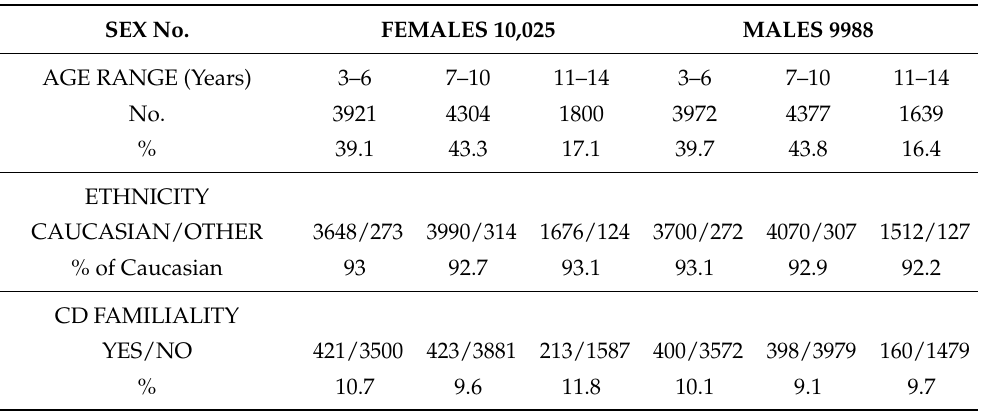
Table 4. Demographic data of 20,013 children who underwent POCT in